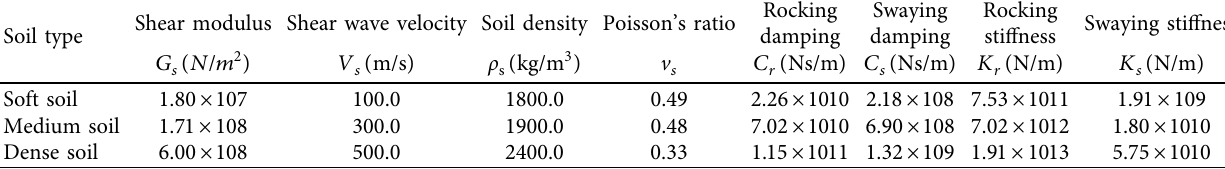
Table 2: Soil parameters